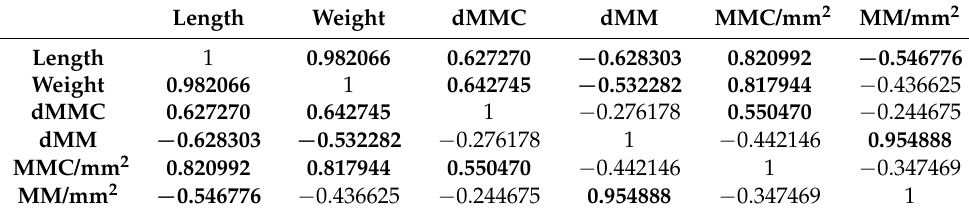
Table 1. Pearson correlations between MMCs and MMs density (µm 2 /mm 2 ) and number per mm 2 and fish biological parameters (LJFL and TW) ( n = 50). Significant correlations ( p < 0.05) are displayed in bold.